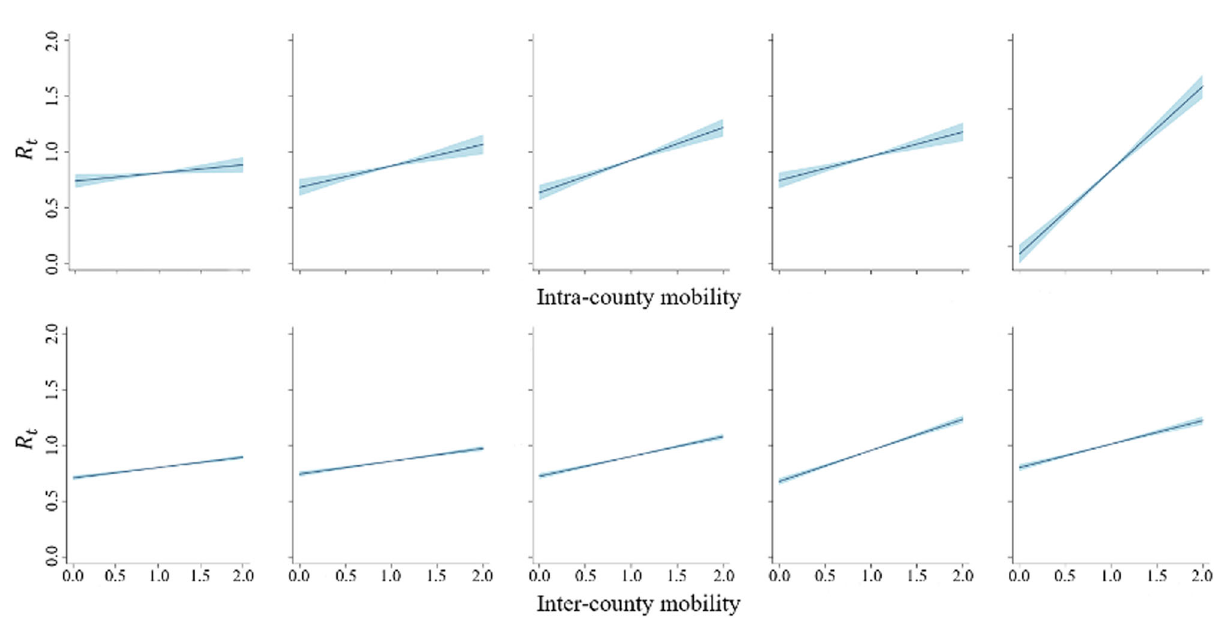
Fig. 6 The marginal effects of intracounty mobility (IntraM) and intercounty mobility (InterM) on R t across different vulnerability levels. The two rows of charts from left to right correspond to vulnerability level 1 to vulnerability level 5.